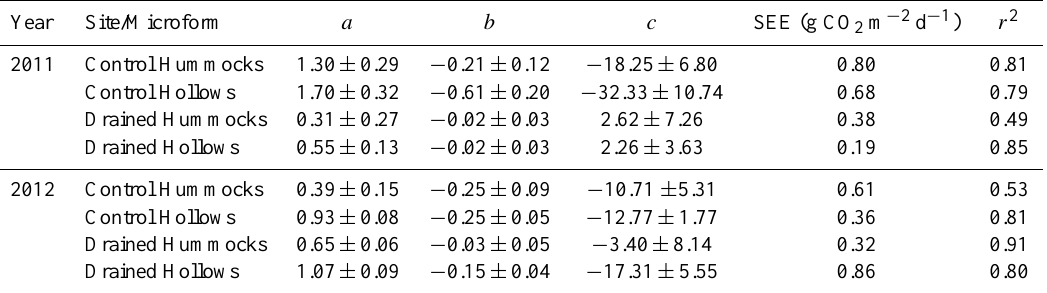
Table 2. Estimated regression coefficient values ( ± SE), standard error of the estimate (SEE) and goodness of fit ( r 2 ) for the forest floor respiration ( R ff ) model (Eq. 2) ∗